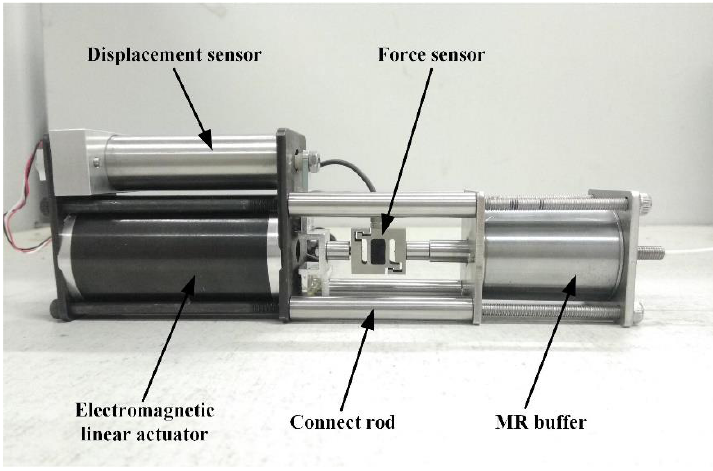
Figure 15. Experimental bench for the buffer force measurement.